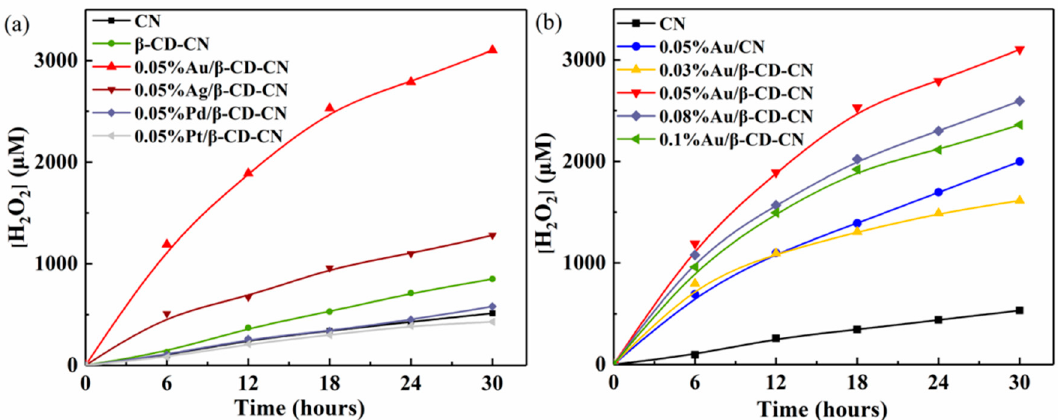
Figure 6. ( a ) Photocatalytic H 2 O 2 production over different co-catalysts loaded CN and ( b ) Au/ β -CD-CN with different loading amounts of Au ( λ > 420 nm).